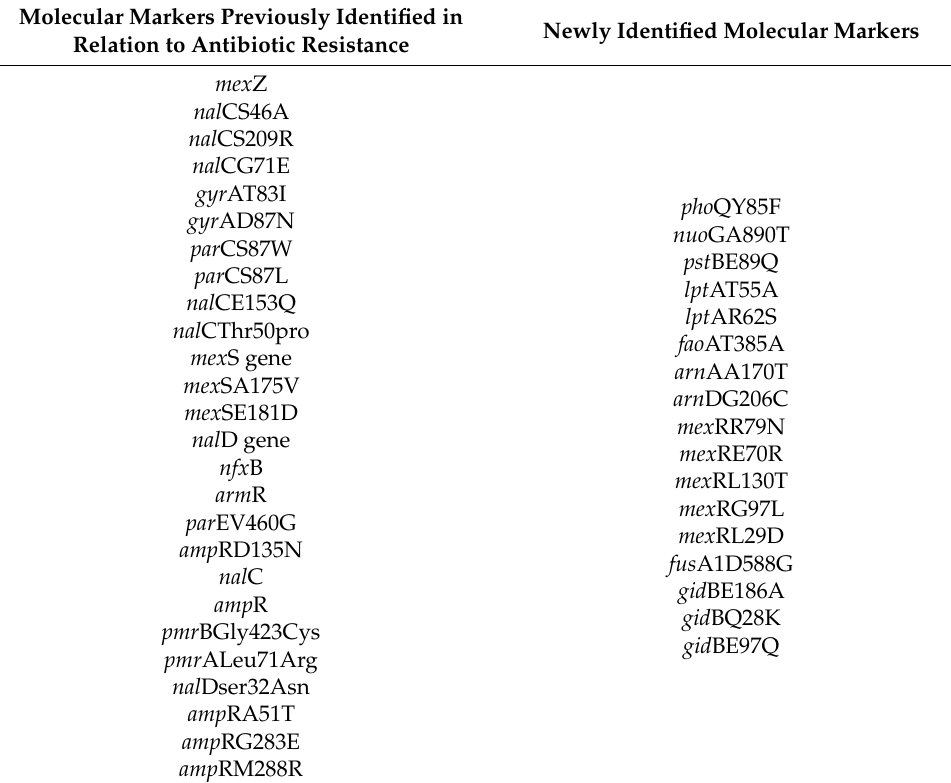
Table 5. Markers tested for their correlation with high-risk